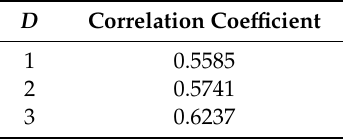
Figure 11. Impacts of the equivalent thermal resistance D on cooling systems. Table 10. Correlation coefficients between the output of renewable energy and the cooling power.